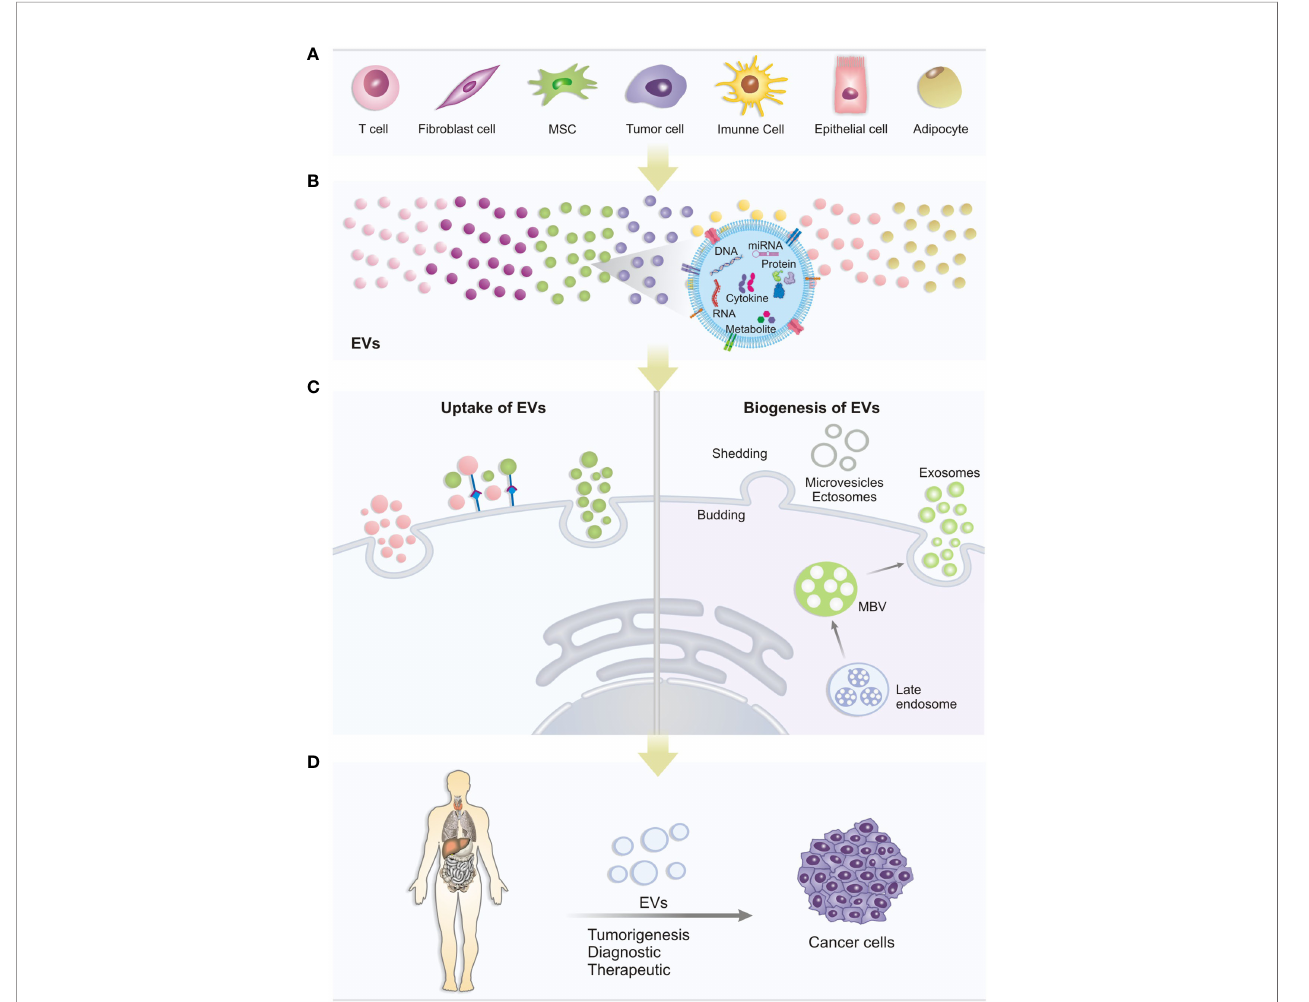
FIGURE 1 | Biogenesis, uptake and role of EVs: (A) Different cell types can release different types of EVs under normal physiological or pathological conditions. (B) The EVs produced may contain several important molecules for cell communication, such as DNA, miRNA, Cytokines, proteins and metabolites that can trigger different biological responses in recipient cells. (C) Uptake of EVs: the mechanisms of extracellular vesicles-mediated transfer may be via target receptors present in the cytoplasmic membrane or direct fusion with the membrane. Interaction with membrane receptors can activate signaling pathways triggering cellular changes. Likewise, EVs, when fusing with the membrane, can release its content and generate cellular changes. Biogenesis: EVs can be produced by cells in different ways: Multivesicular bodies can develop from early endosomes and fuse with the plasma membrane releasing vesicles (exosomes) or, EVs can form by budding from the outer plasma membrane of the cell, with release of microvesicles to the extracellular environment. (D) In studies on the association of EVs with cancer, the potential of content carried by EVs to be used as a tool for new diagnostic strategies and therapeutic targets has been